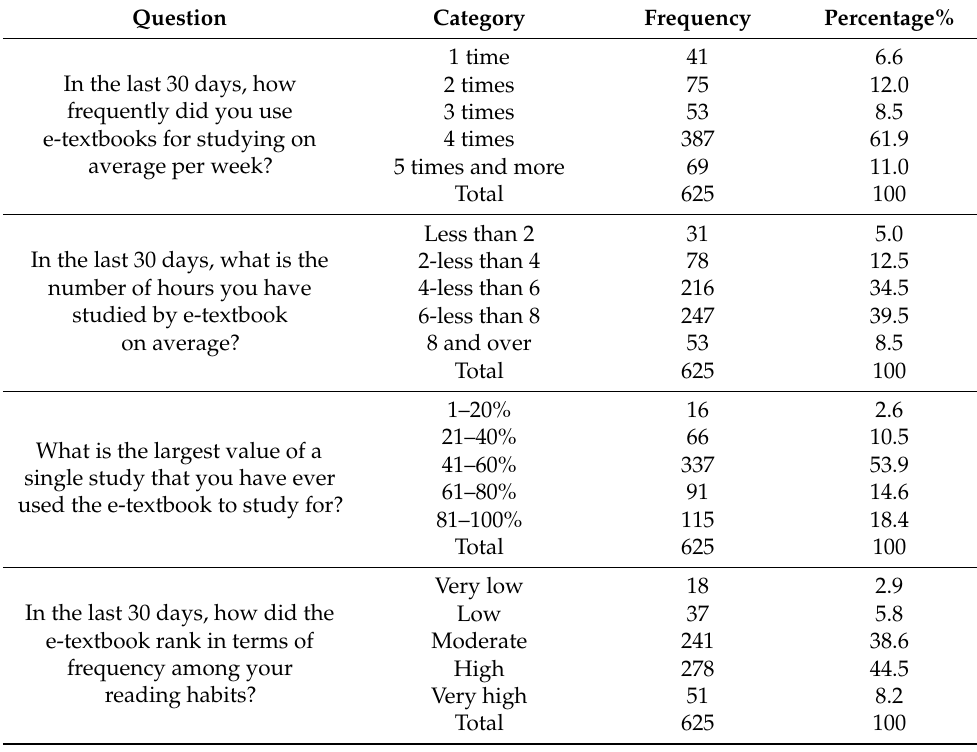
Table 2. Description of the respondents’